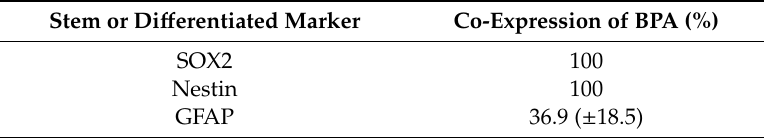
Figure 3. Uptake of BPA in tumors of an orthotopic mouse model. Tumor samples were co-stained with BPA and ( a ) SOX2, ( b ) Nestin or ( c ) glial fibrillary acidic protein (GFAP). Scale bar: 50 µm. Table 3. Percentages of stem marker (SOX2 or Nestin) + or differentiated marker (GFAP) + /BPA + cells among glioma cells in tumors of orthotopic xenograft developed from no. 1 glioma stem cells (GSCs).